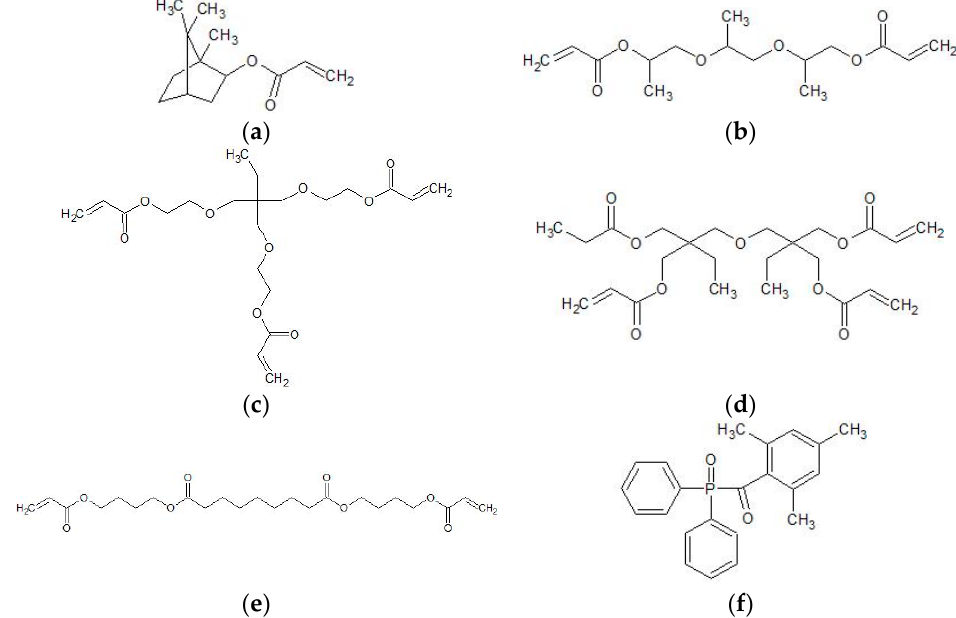
Figure 1. Components of the ultraviolet (UV)-curable matrix material: ( a ) isobornyl acrylate (IBOA), ( b ) tripropylene glycol diacrylate (TPGDA), ( c ) trimethylolpropane (EO) 3-trimethylolpropane triacrylate (TMPEO3TA), ( d ) di(trimethylolpropane)tetraacrylate (DTMPTA), ( e ) polyester acrylate genomer 3364, ( f ) diphenyl(2,4,6-trimethylbenzoyl)phosphine oxide (TPO). Genomer 3364 is a commercial product with a confidential chemical structure. The molecule shown is an example of a polyester acrylate.